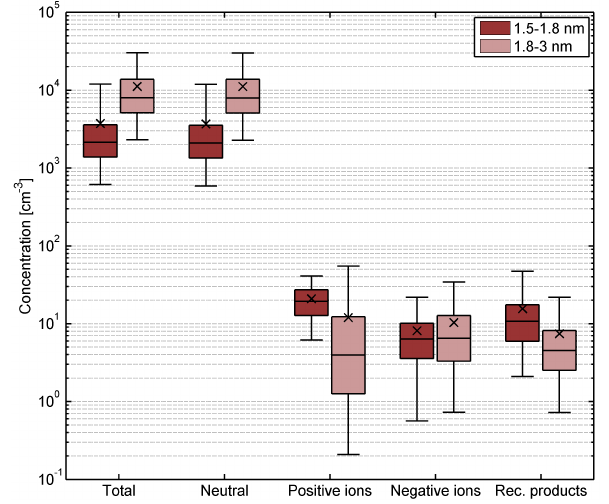
Figure 3. The median concentration of all clusters, neutral clusters, positive ions, negative ions and recombination products in the two size bins (1.5–1.8 and 1.8–3.0nm). The edges of the boxes show the 25th and 75th percentiles and the centers of the boxes represent the median values. The mean values are presented with black crosses. The error bars show the 5th and 95th percentile